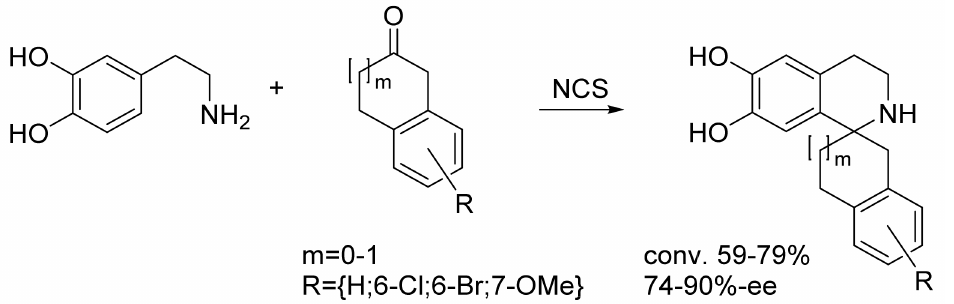
Figure 6. Formation of tetrahydroisoquinolines by Pictet–Spenglerase mutants and the wild-type of the norcoclaurine synthase (NCS) [23].